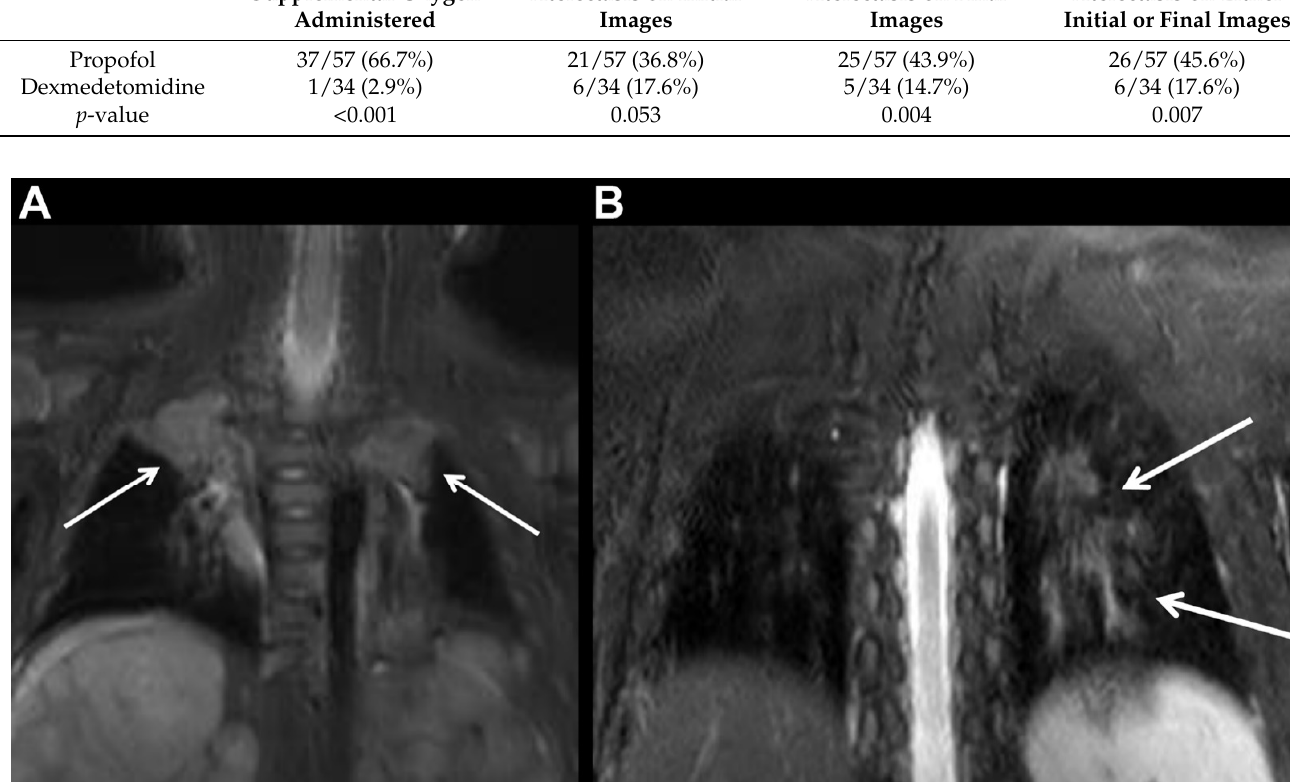
Figure 2. ( A ) A five-month-old male patient diagnosed with neuroblastoma and multiple hepatic metastases was sedated with intravenous propofol for whole-body magnetic resonance imaging. The initial image (coronal short tau inversion recovery image of thoracic level) shows segmental atelectasis (Grade 4; arrow) in both upper lobes. The estimated volume of atelectasis per the total lung volume was 13.6%. ( B ) A six-year-old male patient diagnosed with neurofibromatosis Type I was sedated with intravenous dexmedetomidine. The initial image (coronal short tau inversion recovery image of thoracic level) shows linear atelectasis along bronchovascular bundles (Grade 2; arrow) in the left lower lobe. The estimated volume of atelectasis per the total lung volume was 1.08%. Table 3. Rate of atelectasis occurrence according to the atelectasis grade on initial images.